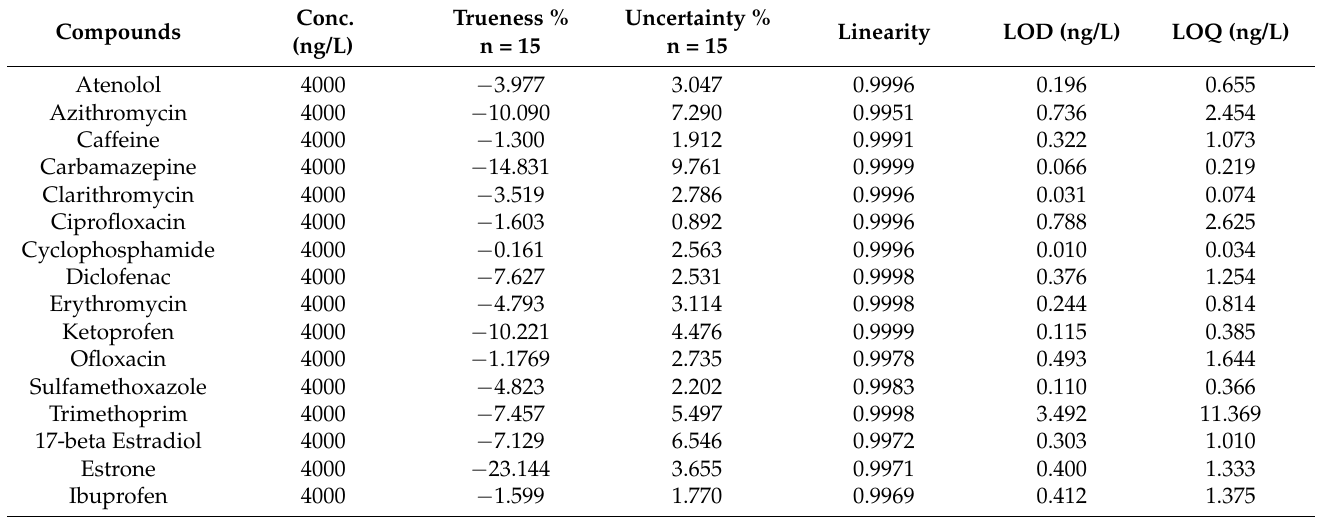
Table 1. Validation results for every target